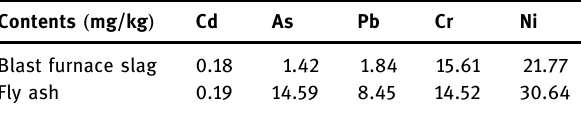
Table 2: The contents of heavy metals in passivation